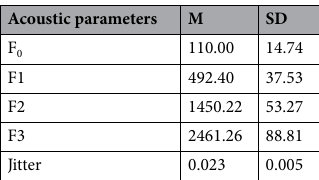
Table 1. Descriptive statistics of acoustic parameters. F 0 is fundamental frequency, F1, F2, and F3 are the first three formant frequencies . N =